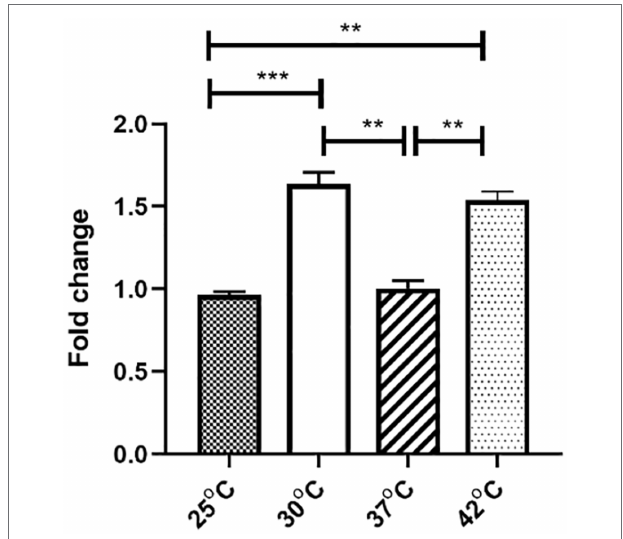
FIGURE 2 | The effect of four temperatures on pGZIncX3 plasmid gene phns expression levels. Variances between different temperature groups were shown with *( p < 0.05), **( p < 0.01), and ***( p <